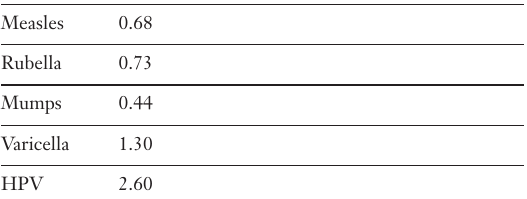
Estimates for the incidence of anaphylaxis: 1994–1996 [111].